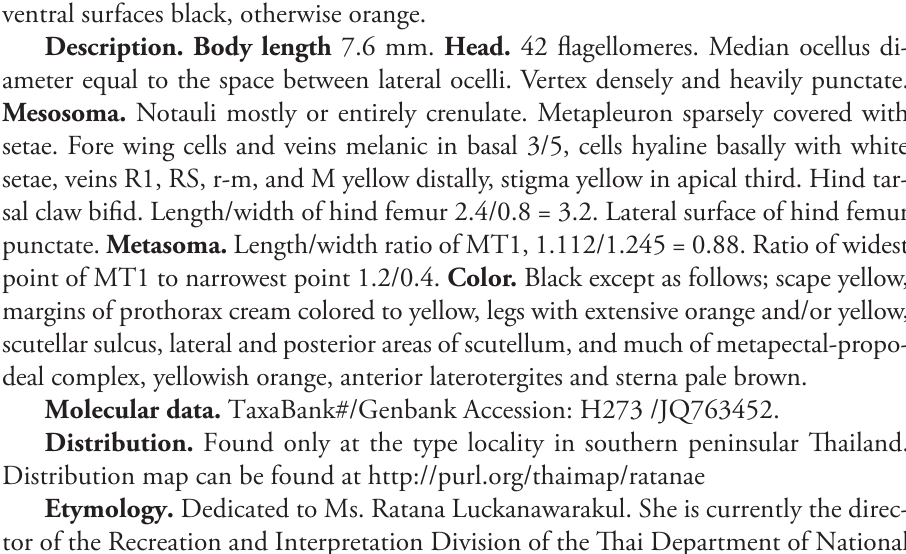
Diagnosis. Hind tibia mostly pale, extreme base cream, apex black, most of dorsal and ventral surfaces black, otherwise orange.